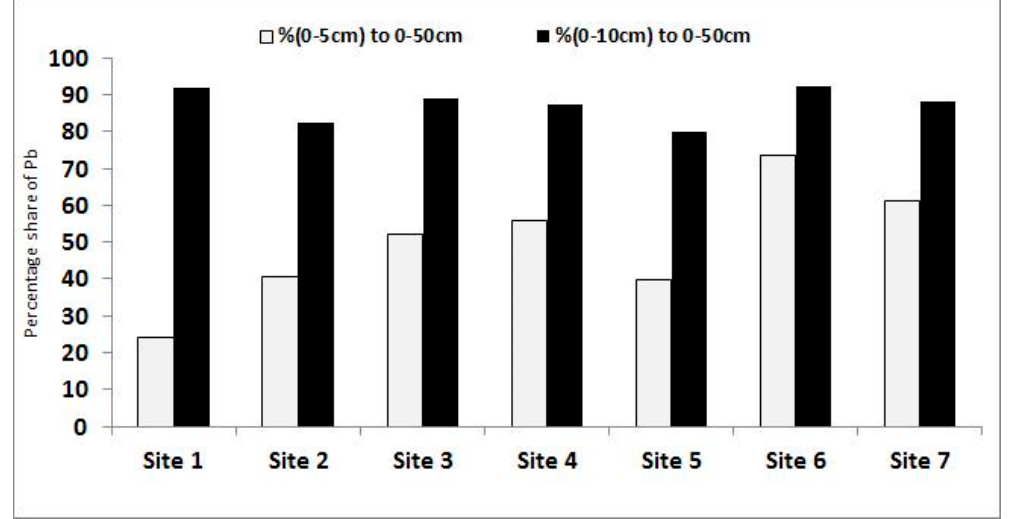
Figure 5. Percentage share of Pb from the 5–0 (litter) and − 5 to − 10 cm layers in the whole (5 to –50 cm) sampling depth.